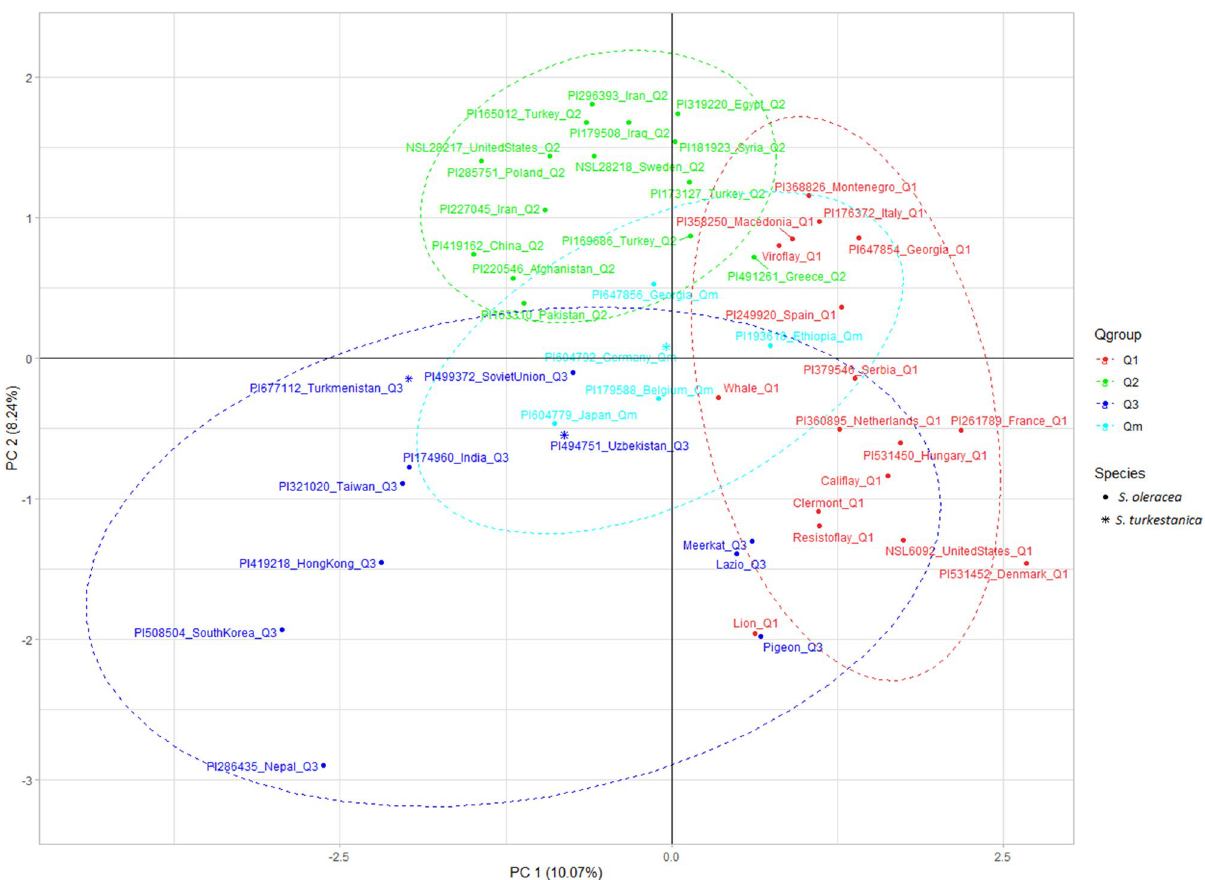
Figure 6. The principal component analysis (PCA) plot for 48 spinach accessions using 34 SSR marker data. The same color code was used for accessions belonging to Q1, Q2, and Q3, and cyan color for the admixed (Qm) population. The S. oleracea and S. turkestanica species are designated with circle and star